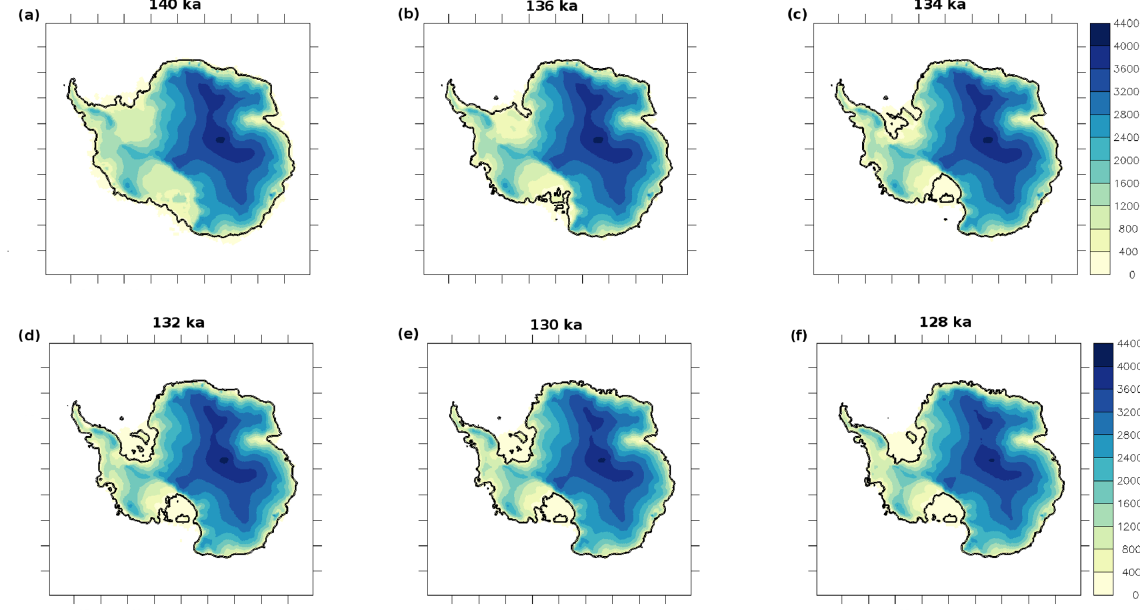
Figure 6. Antarctic ice-sheet elevation at (a) 140ka, (b) 136ka, (c) 134ka, (d) 132ka, (e) 130ka and (f) 128ka as simulated by the GSM (e.g. Briggs et al., 2014). Grounding lines are in